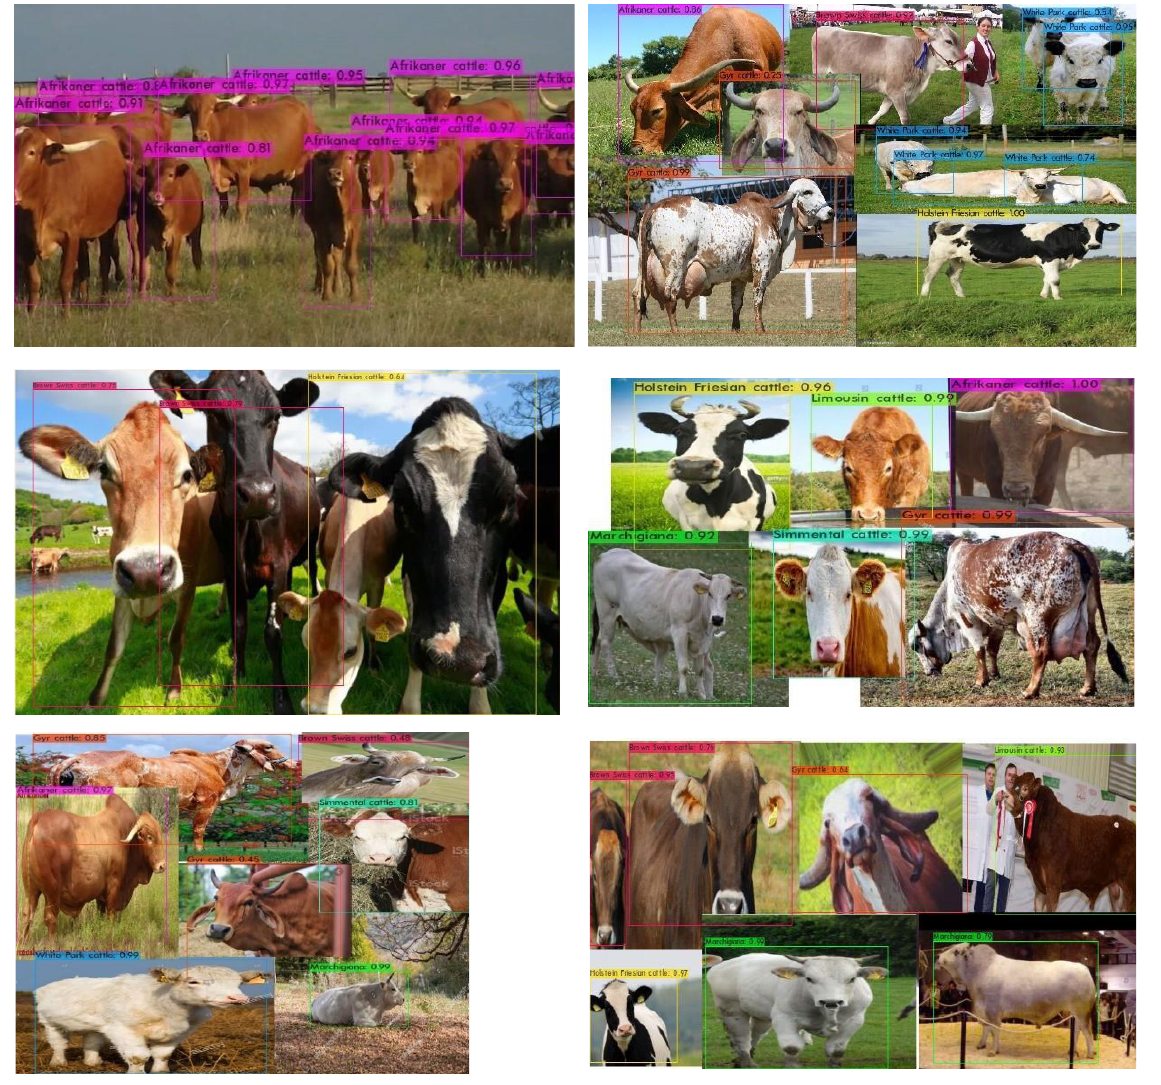
Figure 13. Sample of test images. Table 5. Sample comparison based on detection.